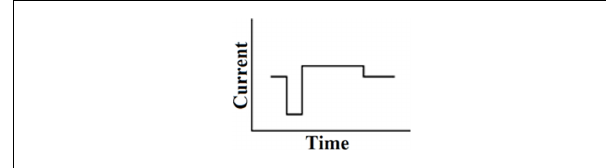
FIGURE 3 | Pseudomonophasic pulse.